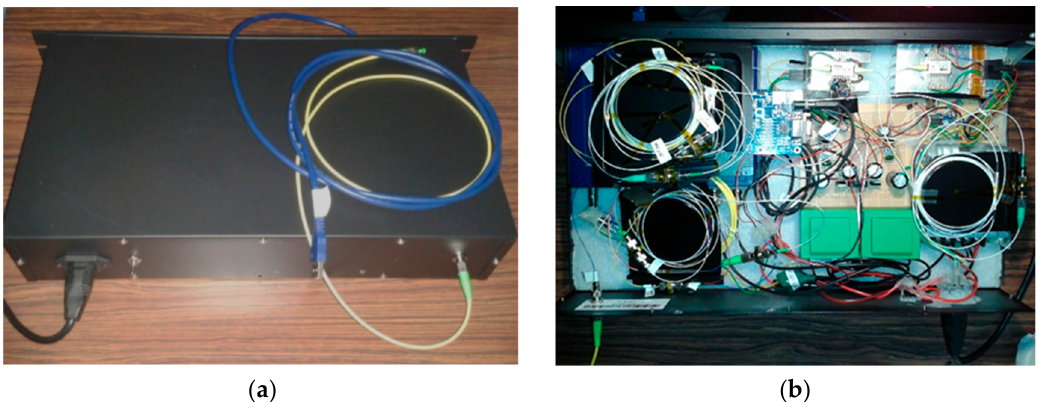
Figure 5. ( a ) External view of the packaged Phase-OTDR system. External connections include a USB3 cable for data communication with the computer, an optical fiber cable to connect with the interrogating optical fiber and a power cord. ( b ) Internal view of optoelectronic components arrangement. All the functions, alerts and settings are managed by customized software.